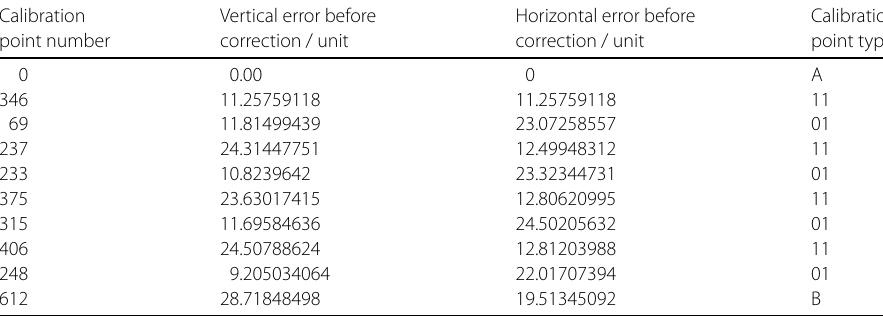
Table 3 Data set 1 route planning